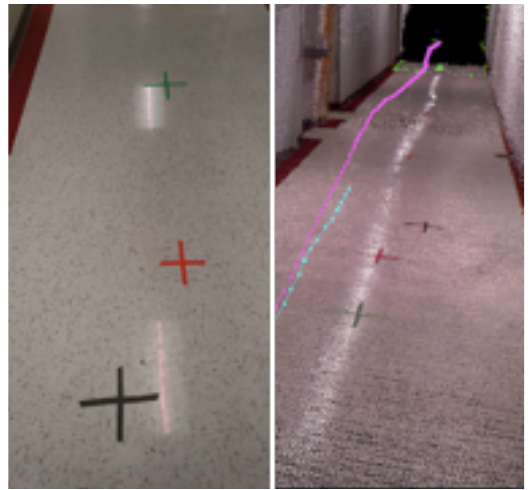
Figure 6. Examples of markers (left), in which CP is denoted in red, test point is in black and green; (Right) shows markers in the 3D model.